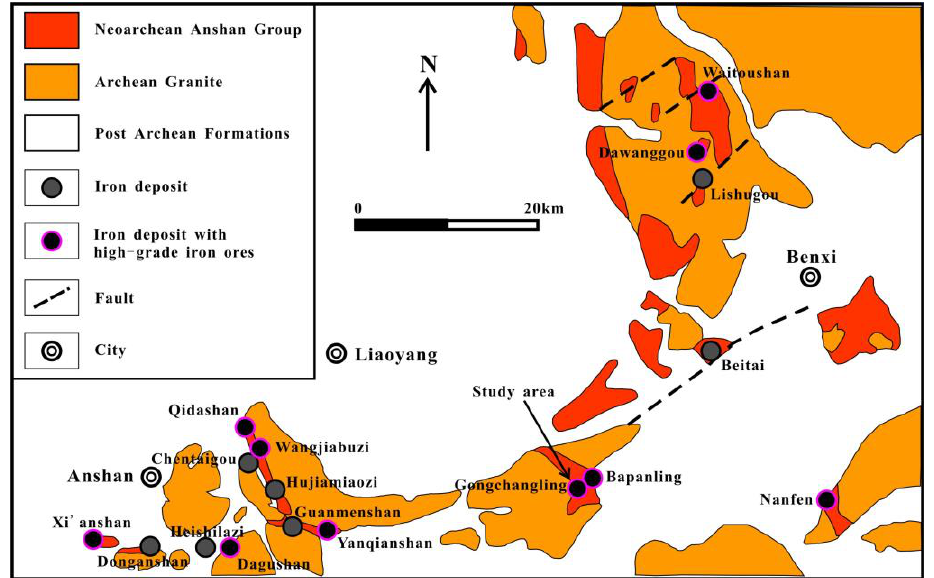
Figure 2. Geological map showing the distribution of the BIF-related high-grade iron deposits in the Anshan-Benxi area, Liaoning Province, China (modified from Li et al., 2015 [17]).